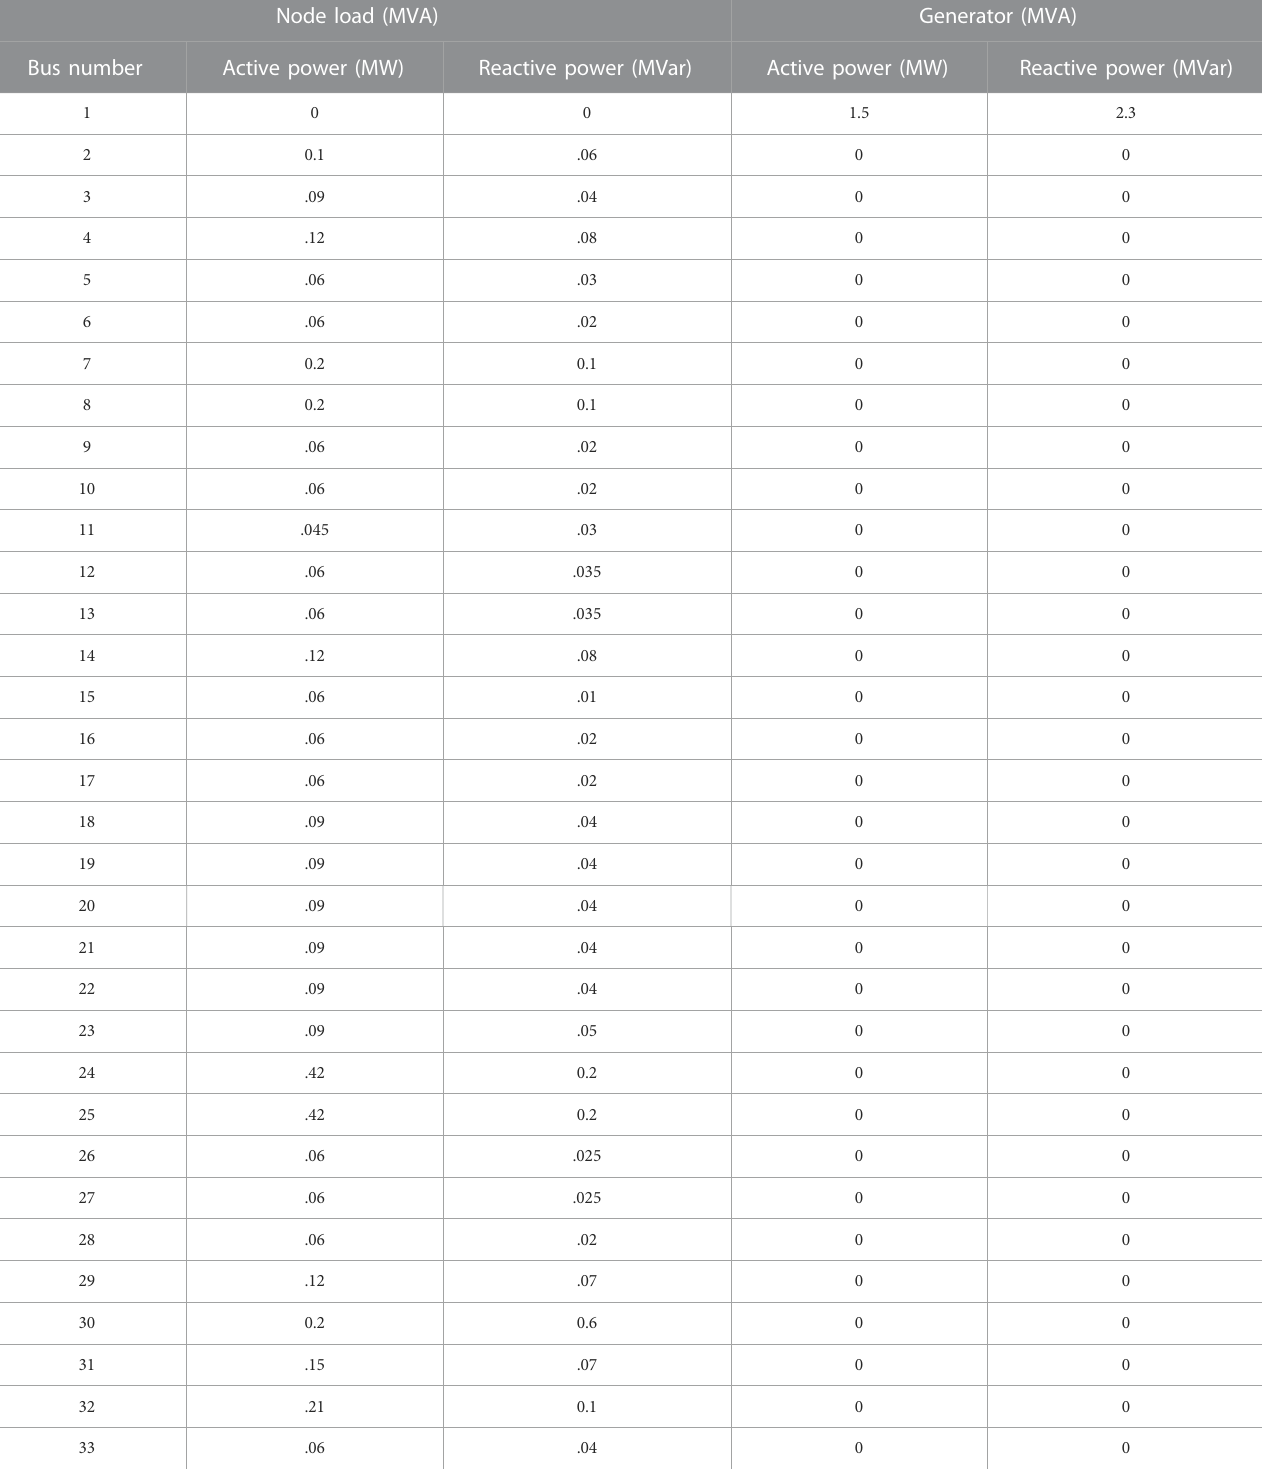
TABLE 1 Load and generator parameters of the standard IEEE 33-node DN